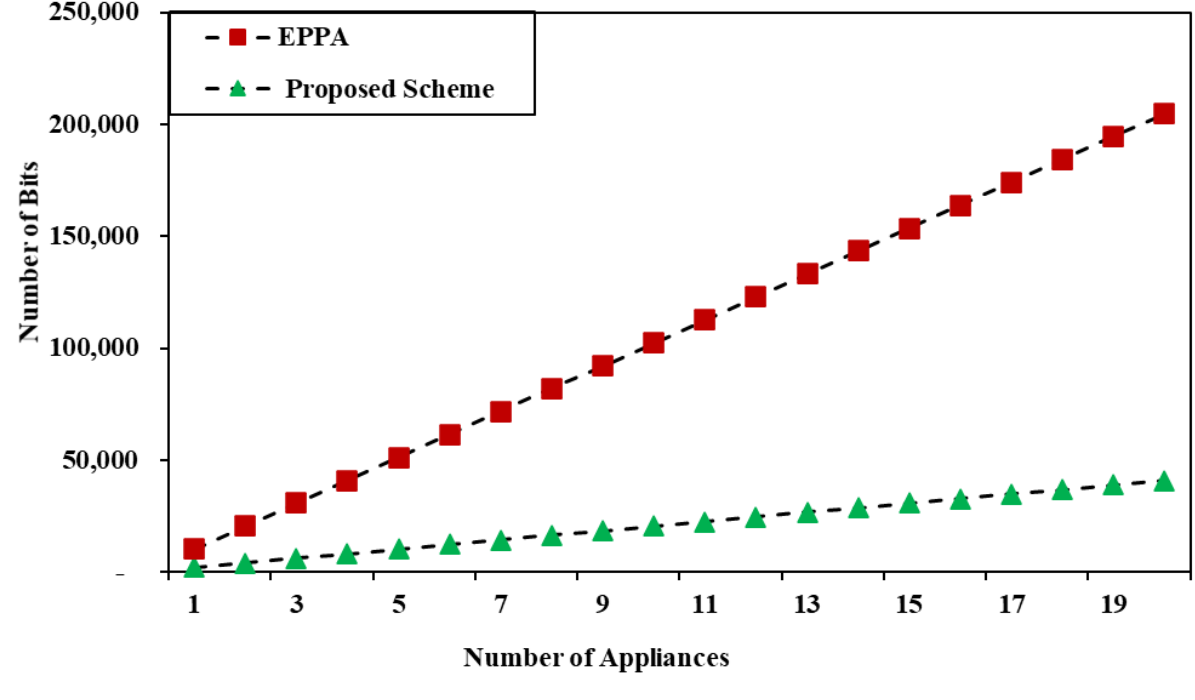
Figure 2. Communication overhead from home appliances to sink